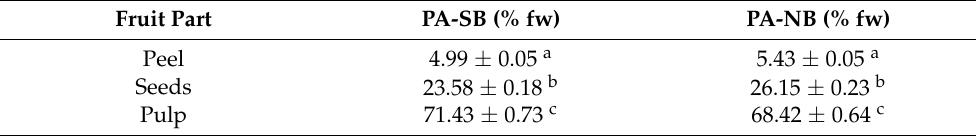
Table 1. Proportion of fruit structural parts of two P. alkekengi phenotypes (PA-SB and PA-NB). Fruit